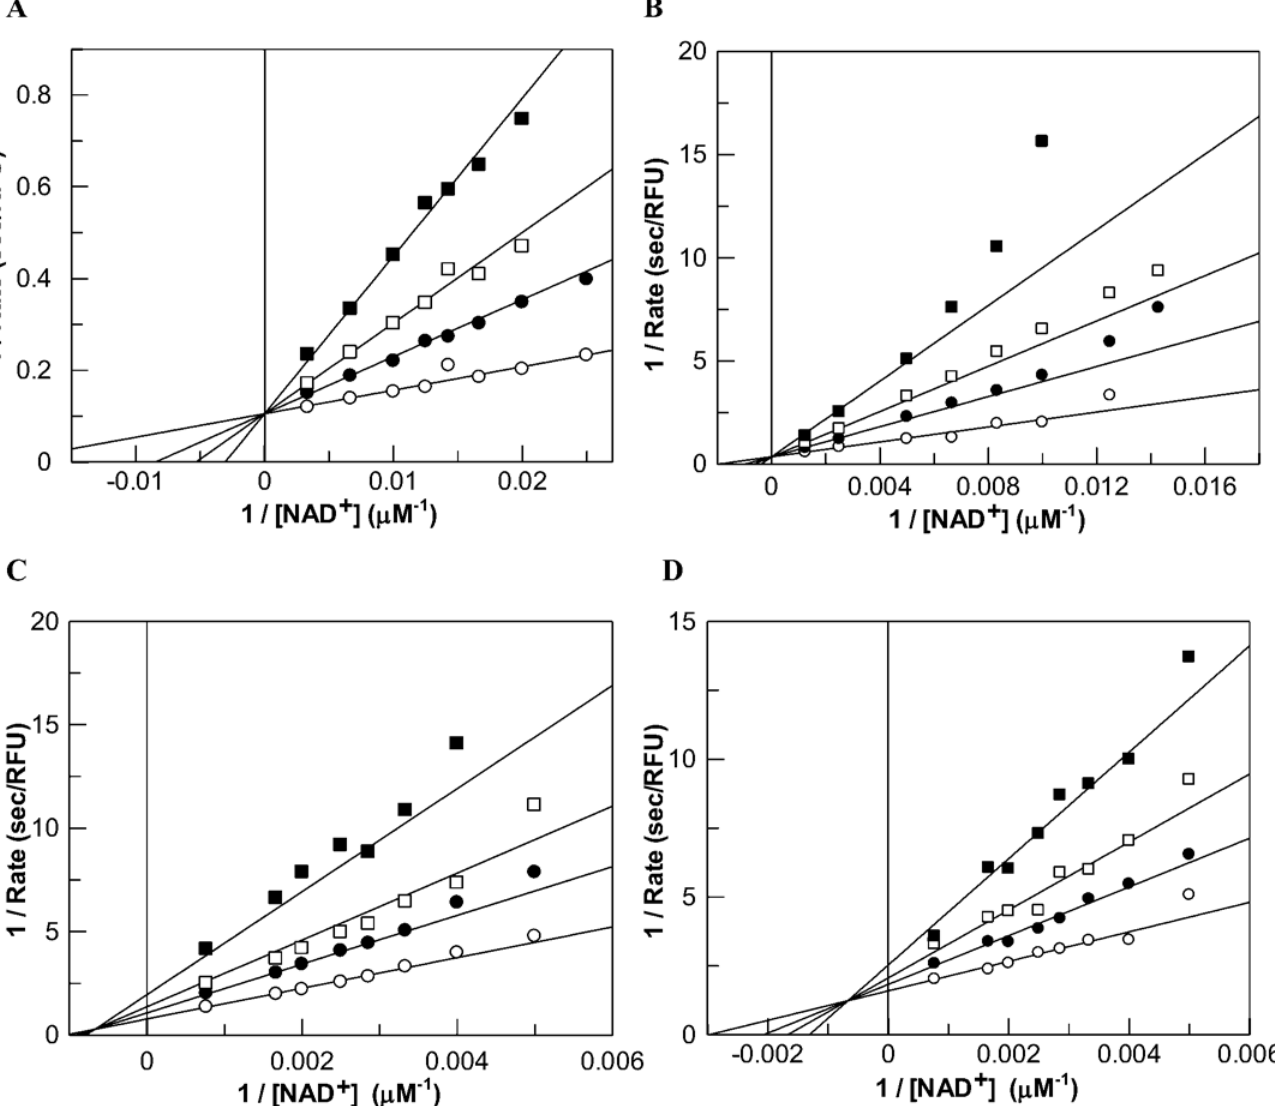
Fig 7. Nicotinamide Inhibition of SIRT5 Variants and SIRT1. Nicotinamide exhibits competitive inhibition against NAD + during the wild-type SIRT5 and its Y102A mutant catalyzed desuccinylation reactions (A and B); mixed type of inhibition against NAD + during the Y102A/R105I SIRT5 mutant and SIRT1 catalyzed deacetylation reaction (C and D). The wild-type SIRT5 catalyzed reactions (A) were performed in the presence of 100 μ M Ac-SucLys-AMC and varying concentrations of NAD + (from 40 to 300 μ M) in the presence of 0, 25, 50 and 100 μ M concentrations of nicotinamide. The Y102A mutant catalyzed reactions (B) were performed in the presence of 500 μ M Ac-SucLys-AMC and varying concentrations of NAD + (from 70 to 800 μ M) in the presence of 0, 50, 100 and 200 μ M nicotinamide. The Y102A/R105I mutant catalyzed deacetylation reactions (C) were performed in the presence of 500 μ M Fluo-de-lys 1 acetylated substrate, and varying concentrations of NAD + concentration (from 200 to 1300 μ M), in the presence of 0, 100, 200 and 400 μ M nicotinamide. SIRT1 reactions (D) were performed in the presence of 100 μ M Fluo-de-lys 1 acetylated substrate, and varying concentrations of NAD + (from 40 to 300 μ M) in the presence of 0, 50, 100, and 200 μ M nicotinamide. Data were fitted using DYNAFIT software and the derived K i values are summarized in Table